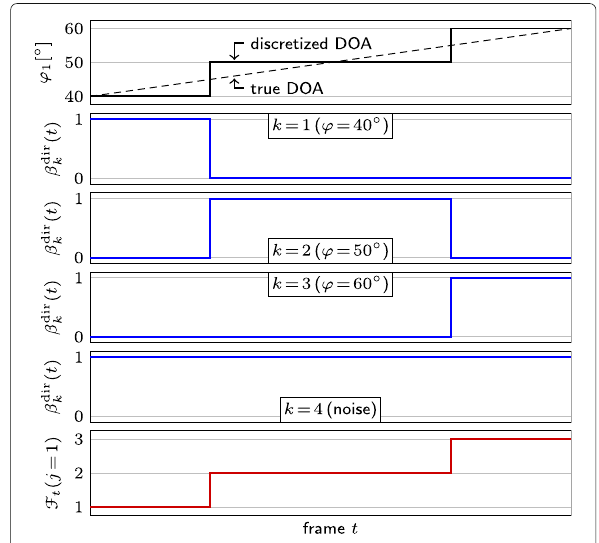
( t ) for J = 1 speaker moving Fig. 5 DOA time annotations (DTAs) β dir k from ϕ = 40 ◦ to 60 ◦ . This results in D = 3 discrete directions, and thus K = 4components.Thefunction F t ( j ) specifies,foreachframe,which component corresponds to the j -th speaker. Note that DTAs and F ( j ) are determined solely by the DOA estimates. Nevertheless, the t DTAs are unique, and thereby enable to enforce a fixed permutation